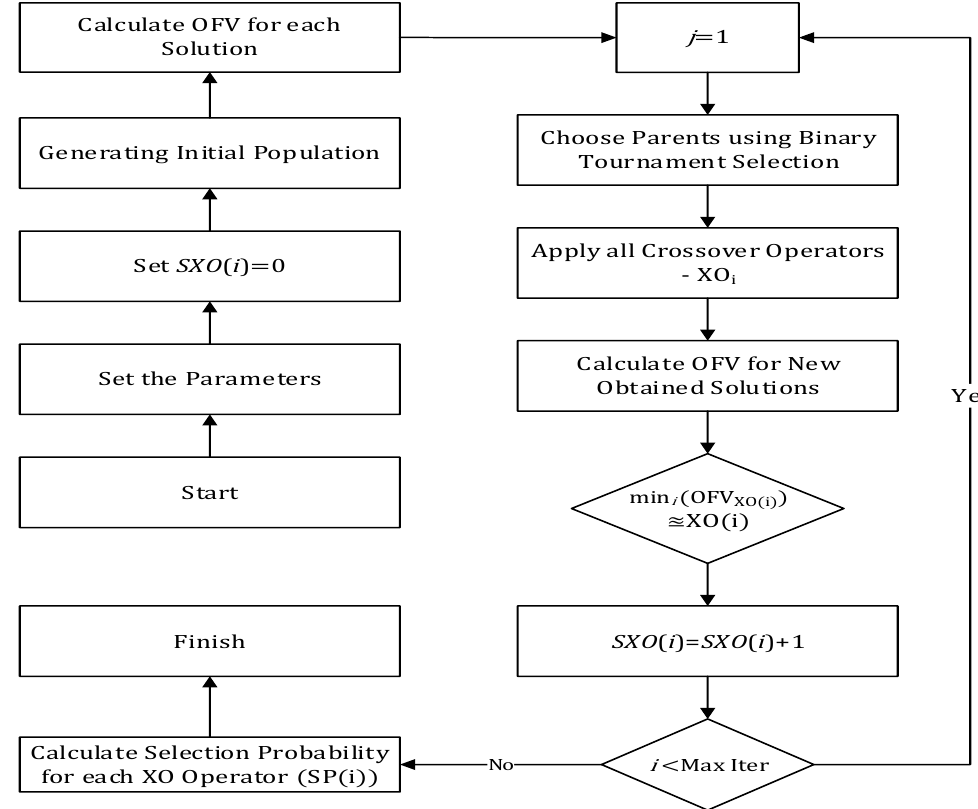
Figure 6. Flowchart of the initialization